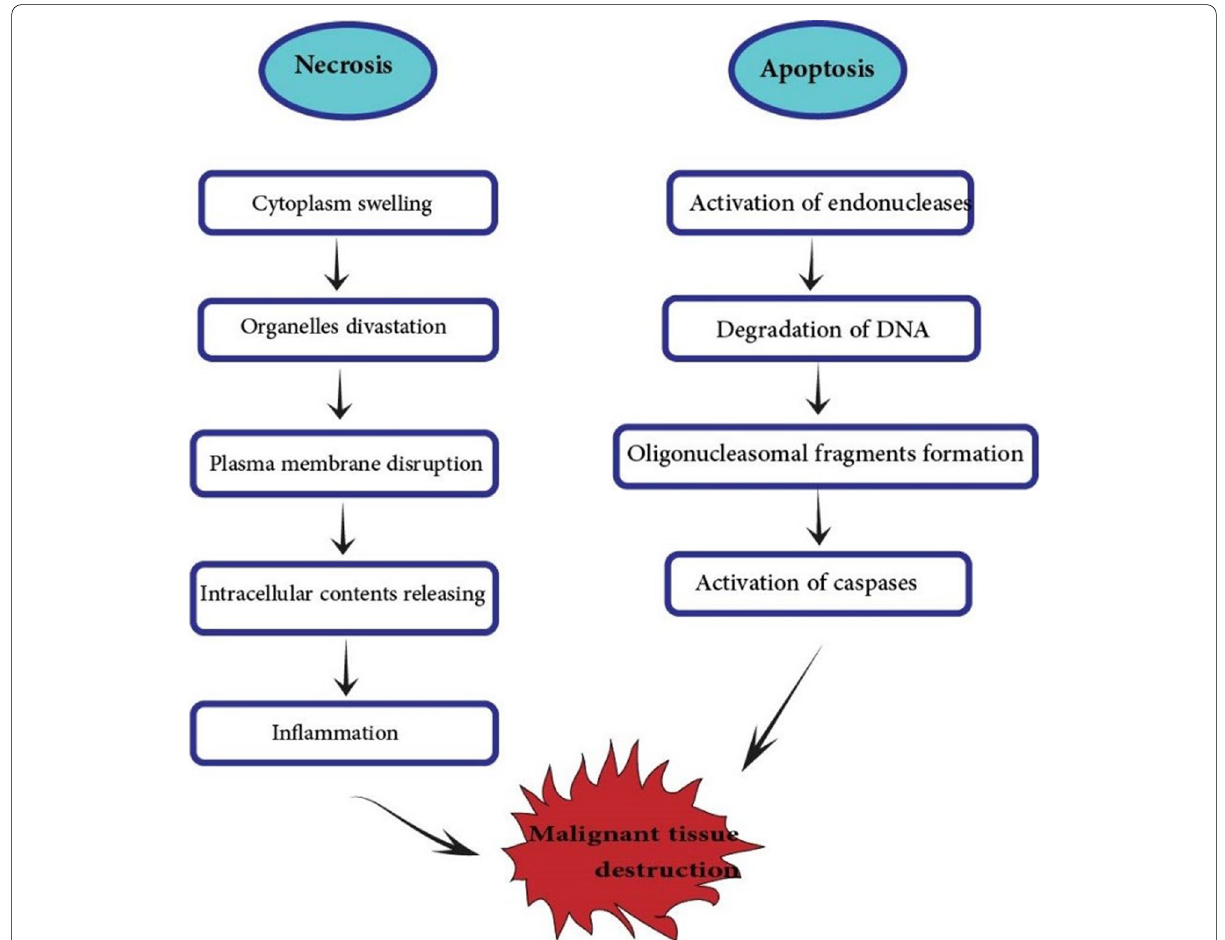
Fig. 2 Mechanisms of necrosis and apoptosis induced by